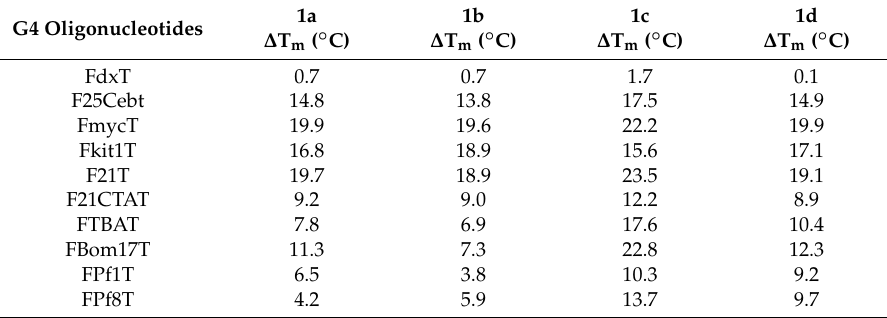
Table 3. Stabilization profile of 1a – d (5 µM) toward various G4 oligonucleotides. G4 Oligonucleotides